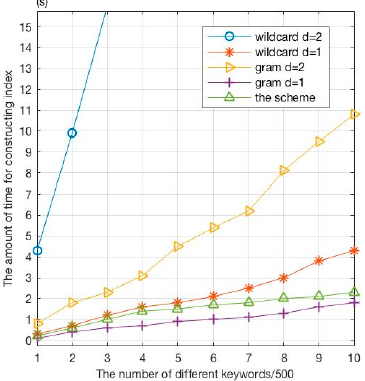
Figure 6. Time consumption for index construction.